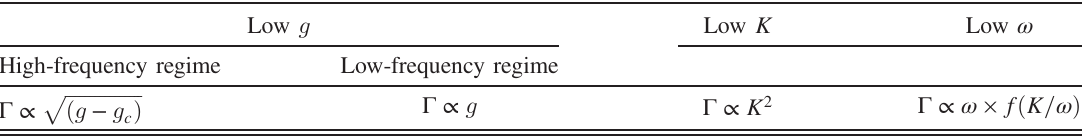
TABLE I. Limiting scalings of instability rates in the thermodynamic limit, in terms of the interaction strength g , the modulation amplitude K , and frequency ω . The high- and low-frequency regimes are defined through a comparison between ω and the free-particle effective bandwidth (see Sec. III